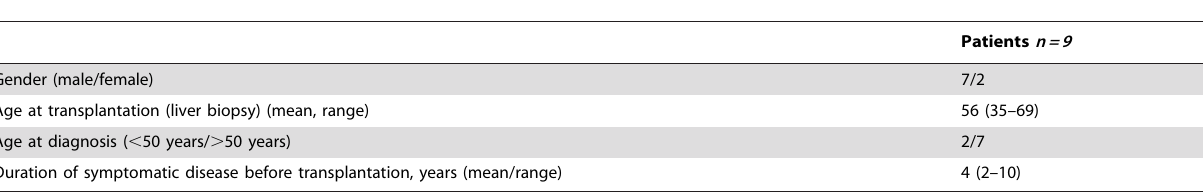
Table 1. Clinical data on patients used in the